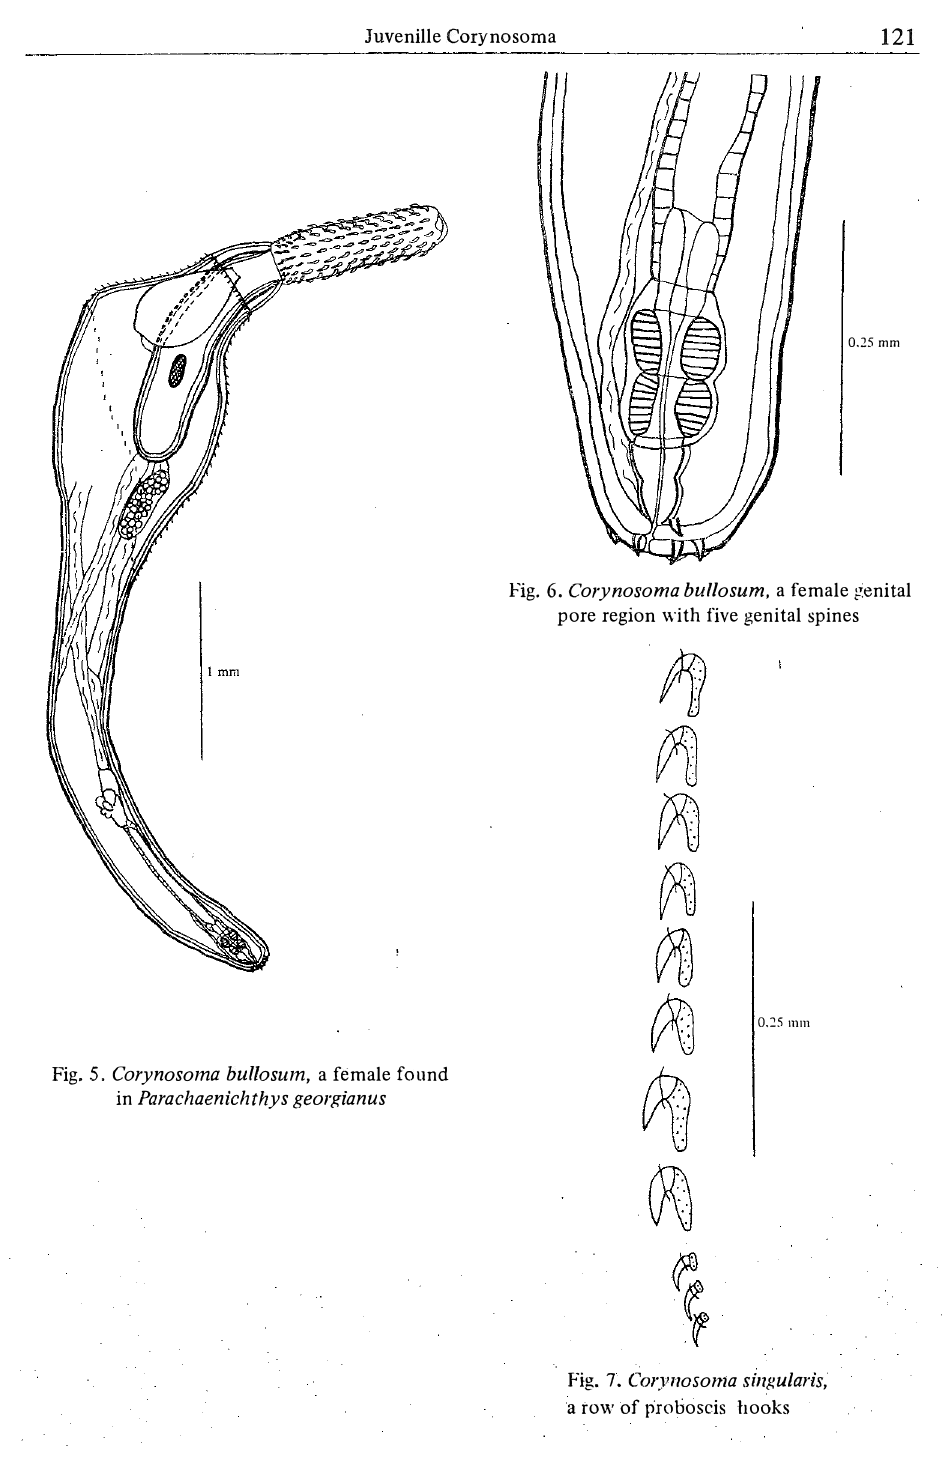
Fig. 7. Corynosoma sin!(ularis, a row of proboscis